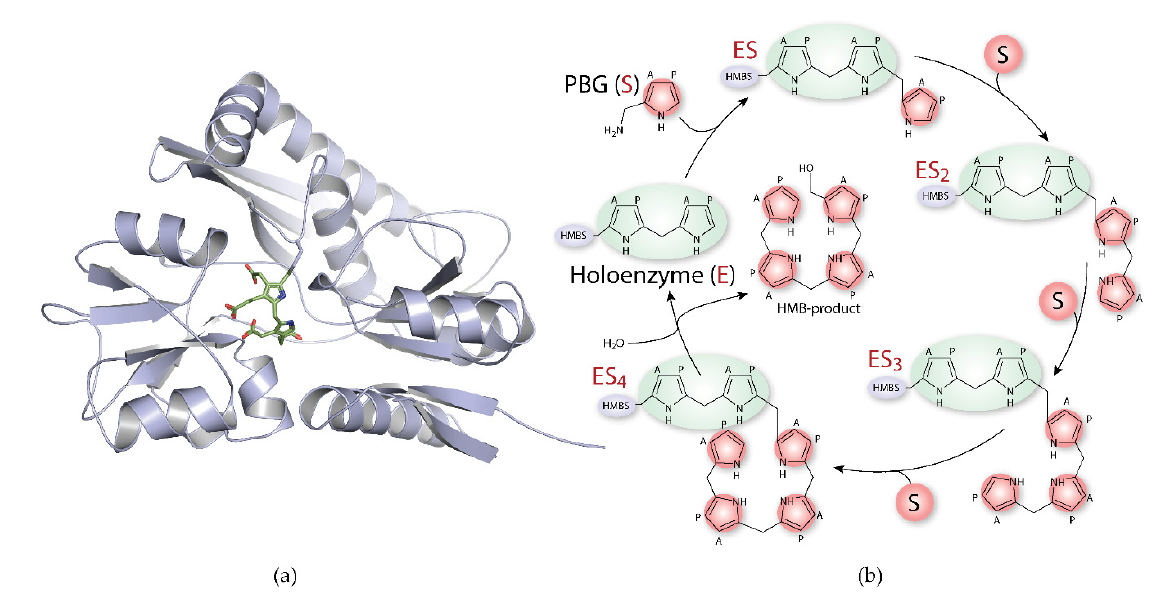
Figure 3. The pyrrole chain elongation catalysed by hydroxymethylbilane synthase. Hydroxymethylbilane synthase (HMBS) and the pyrrole chain elongation. ( a ) Cartoon representation of HMBS crystal structure (blue; PDB ID: 3ECR) with the dipyrromethane (DPM) cofactor in the centre. The housekeeping HMBS is a monomeric protein of 39.3 KDa. ( b ) HMBS (blue) with the DPM cofactor (2 × PBG molecules; green) constitute the holoenzyme (E) and bind four PBG substrates (S; red), sequentially, producing enzyme intermediates ES (=ES 1 ), ES 2 , ES 3 and ES 4 . Hydroxymethylbilane (HMB), the linear tetrapyrrole product, is released by hydrolysis. The substrate sidechains are acetate (A) and propionate (P). Figure modified from [76] and [77] .